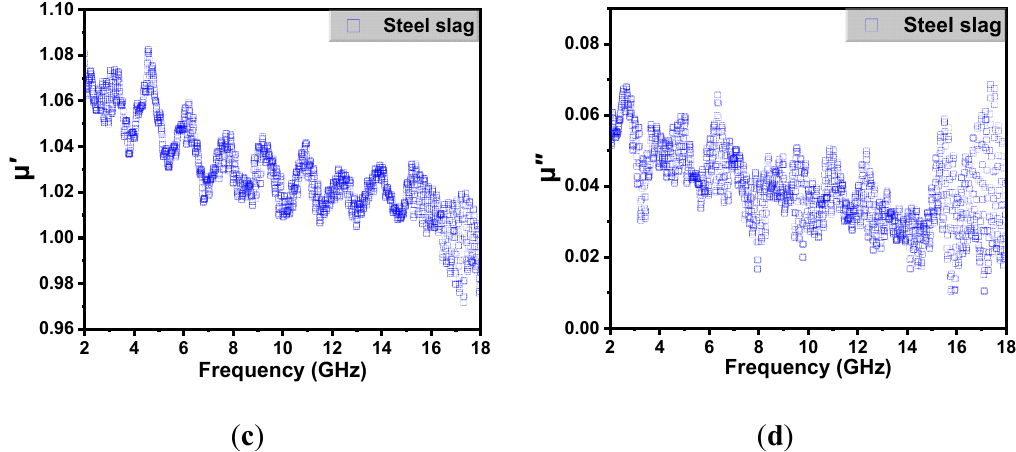
Figure 3. Electromagnetic parameters of steel slag. The real ( a ) and imaginary ( b ) parts of permittivity; the real ( c ) and imaginary ( d ) parts of permeability.